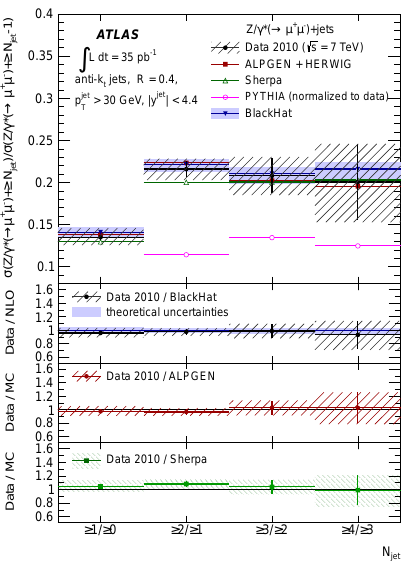
µ + µ − ) + jets production nor- →